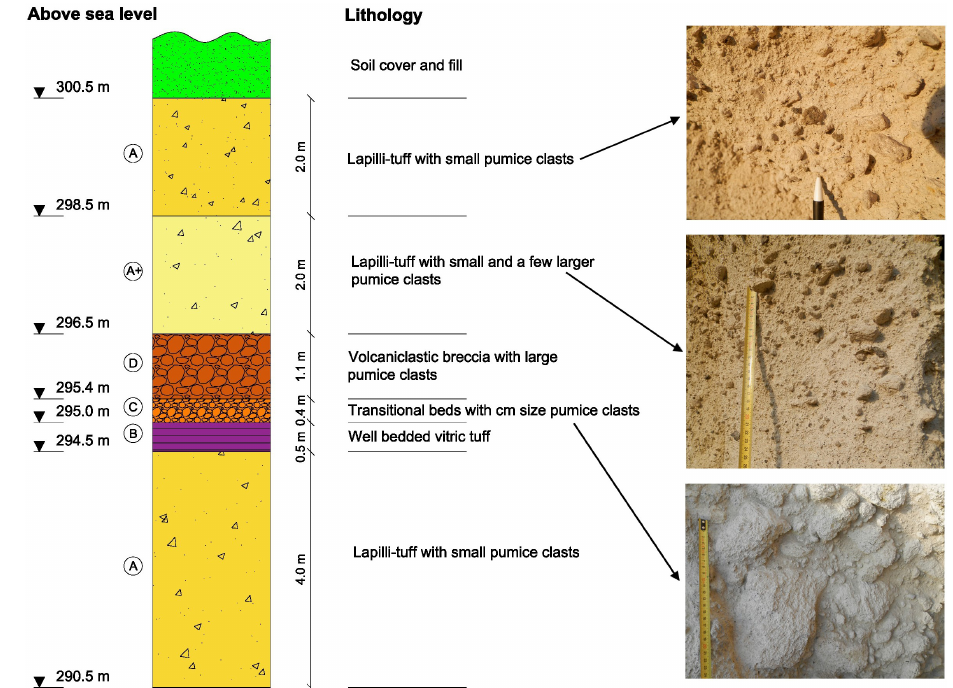
Figure 8. Lithologic column of Sirok Várhegy showing the modelled topmost 10m section of the hill (letters refer to lithologic